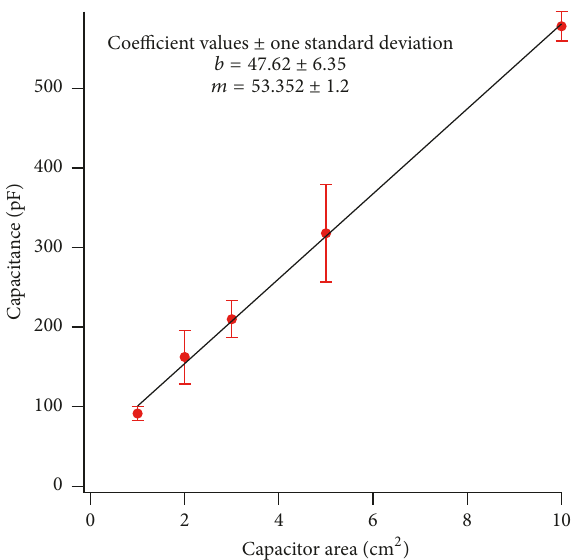
Figure 2: Plot of measured capacitance versus surface area of the pencil graphite capacitor plate. Error bars represent standard devia- tion for replicate capacitors.